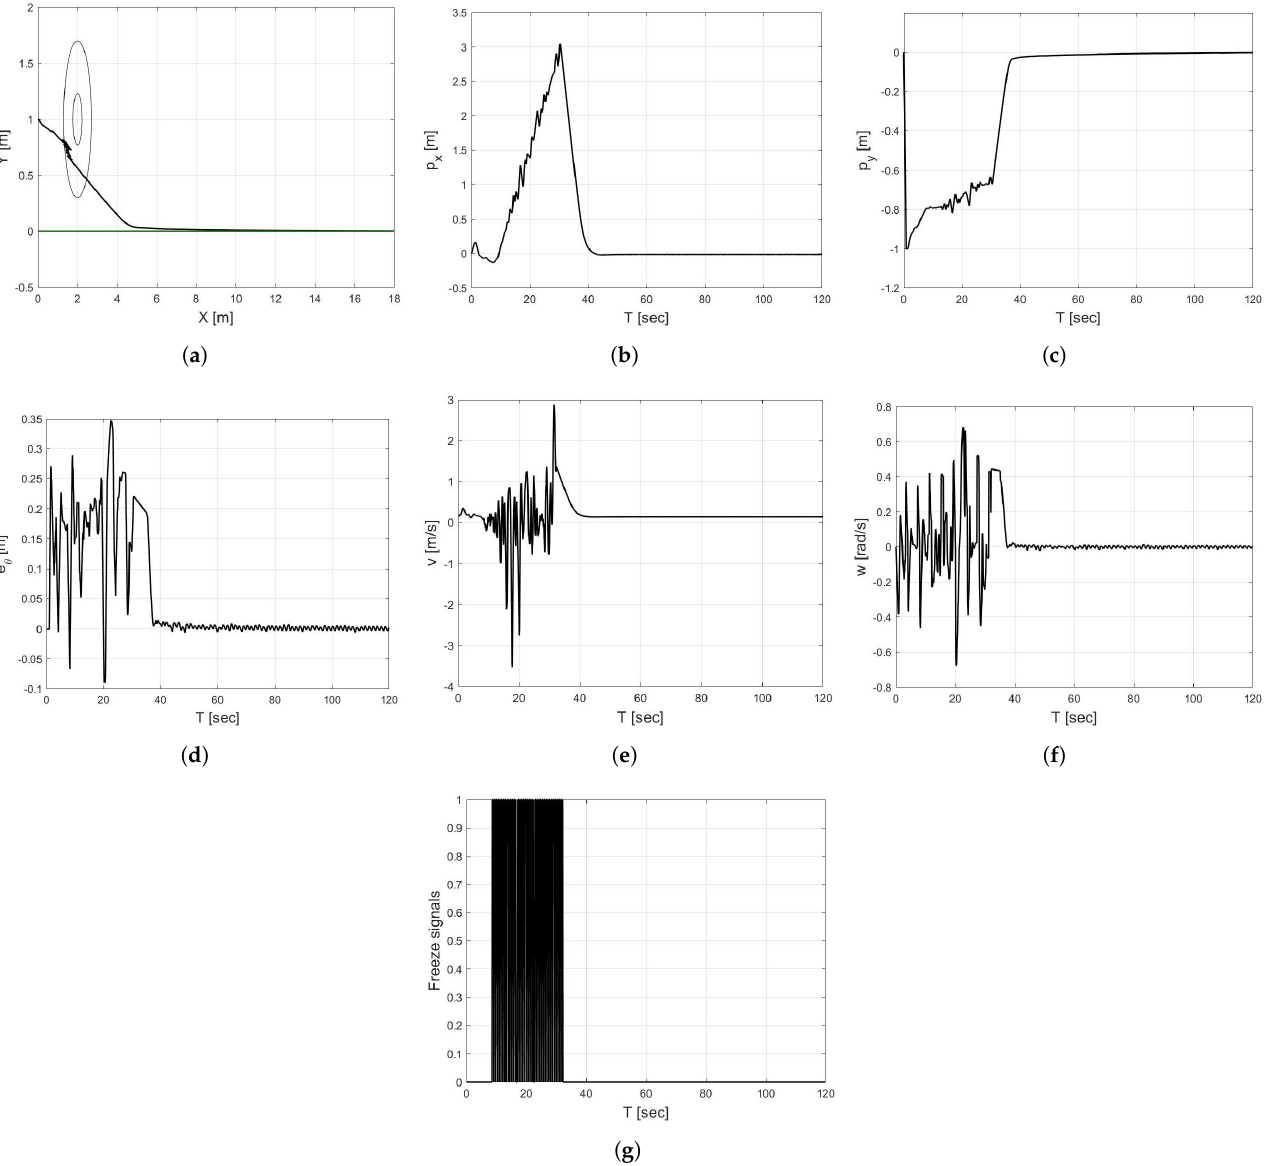
Figure 5. Experiment 1 results—( a ) real and virtual robots path in ( x , y ) -plane; ( b ) position errors in x direction as a function of time; ( c ) position errors in y direction as a function of time; ( d ) orientation errors as a function of time; ( e ) linear velocity control; ( f ) angular velocity control; ( g ) ’freeze’